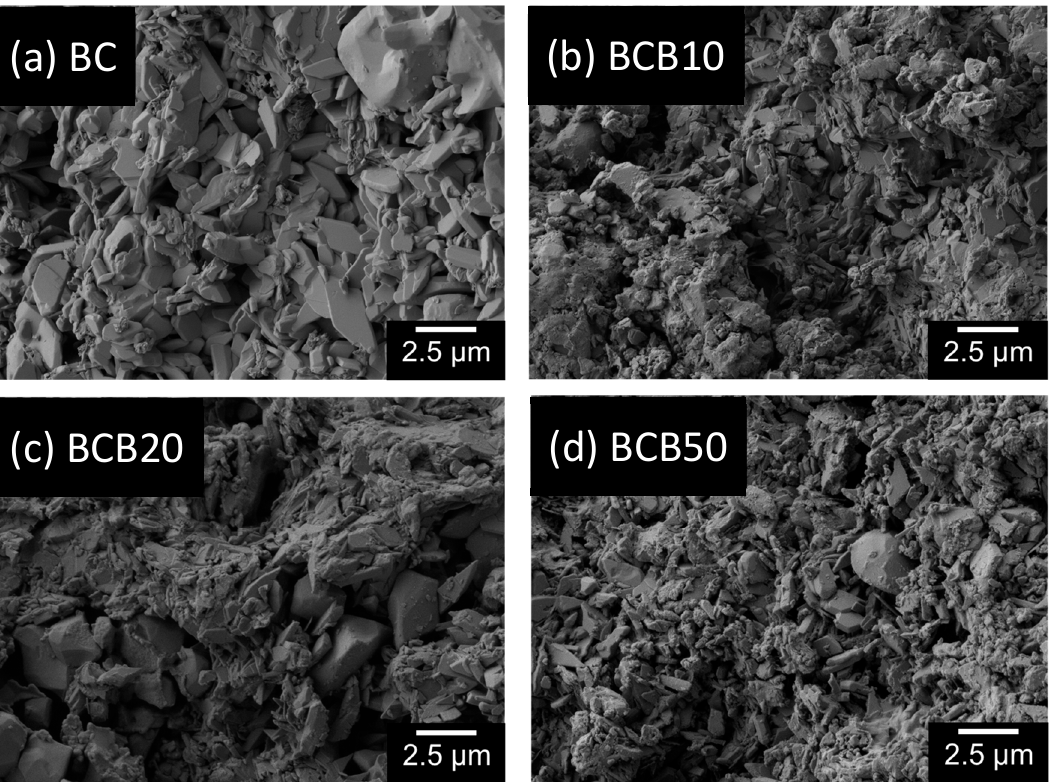
Figure 3. Scanning electron microscopy images of the cement fracture surfaces for ( a ) BC; ( b ) BCB10; ( c ) BCB20; and ( d ) BCB50.